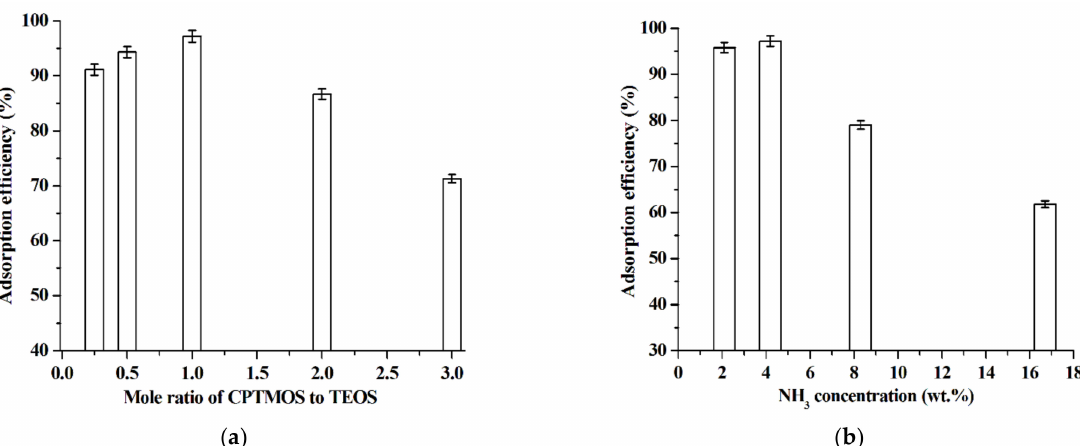
Figure 3. Effect of the mole ratio of CPTMOS to TEOS ( a ) (dosage of [C 4 mim]NTf 2 , 1.0 g; NH 3 concentration, 4.2 wt%; quaternization reaction time, 12 h; mole ratio of MIM to C 3 Cl@SiO 2 of the quaternization reaction, 3.0; adsorption test: [C 3 mim] + Cl − @SiO 2 , 40 mg; baicalin aqueous solution, 5.0 × 10 − 5 mol · L − 1 , pH 5.0, 10 mL; adsorption time, 1 h; adsorption temperature, 25 ◦ C) and NH 3 concentration ( b ) (dosage of [C 4 mim]NTf 2 , 1.0 g; mole ratio of CPTMOS to TEOS, 1.0; quaternization reaction time, 12 h; mole ratio of MIM to C 3 Cl@SiO 2 of the quaternization reaction, 3.0; adsorption test: [C 3 mim] + Cl − @SiO 2 , 40 mg; baicalin aqueous solution, 5.0 × 10 − 5 mol · L − 1 , pH 5.0, 10 mL; adsorption time, 1 h; adsorption temperature, 25 ◦ C) on the adsorption efficiency of [C 3 mim] + Cl − @SiO 2 . Experiments were conducted in